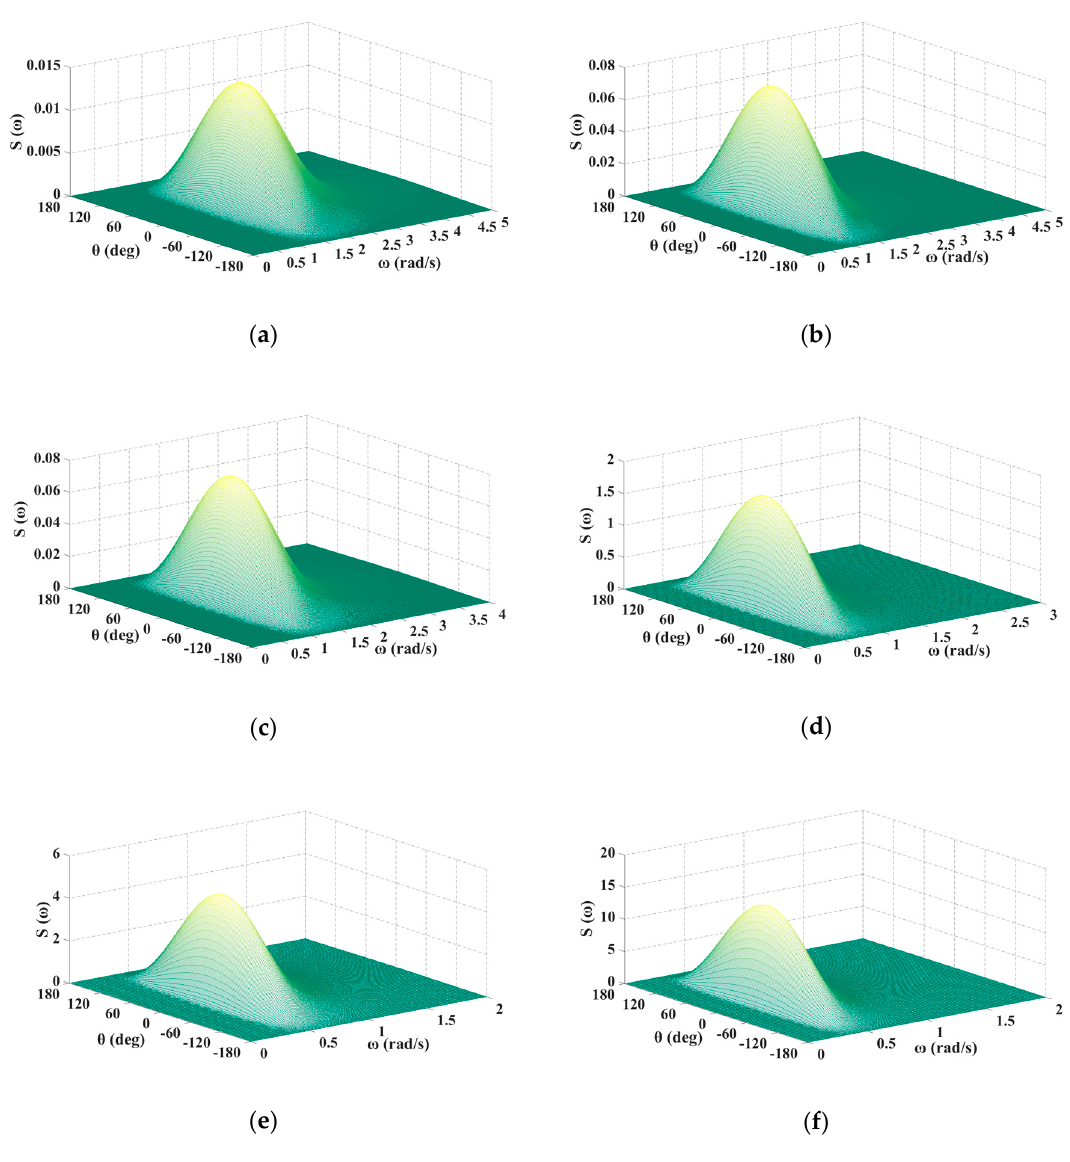
Figure 1. Energy distribution of waves at di ff erent wind speeds. ( a ) The wind speed is 5 m / s; ( b ) the wind speed is 7 m / s; ( c ) the wind speed is 9 m / s; ( d ) the wind speed is 13 m / s; ( e ) the wind speed is 16 m / s; ( f ) the wind speed is 20 m / s.